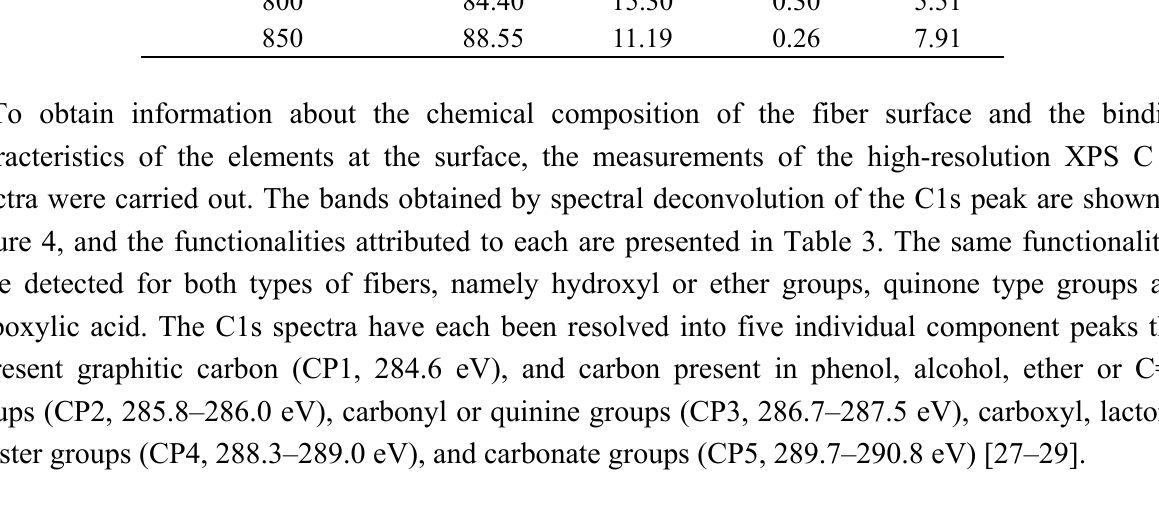
Figure 4. High-resolution X-ray photoelectron spectroscopy (XPS) fitted ( a ) C 1s and ( b ) O1s spectra of BACFs.